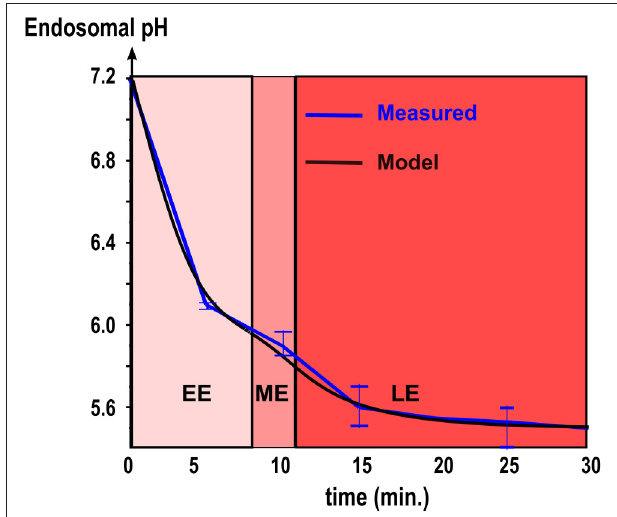
SEM) is compared ±